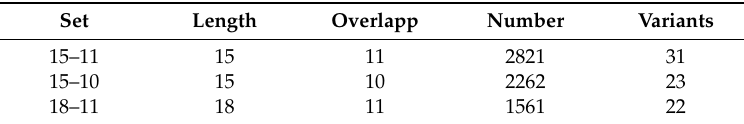
Table 2. Description of the three CoV-2 OLP